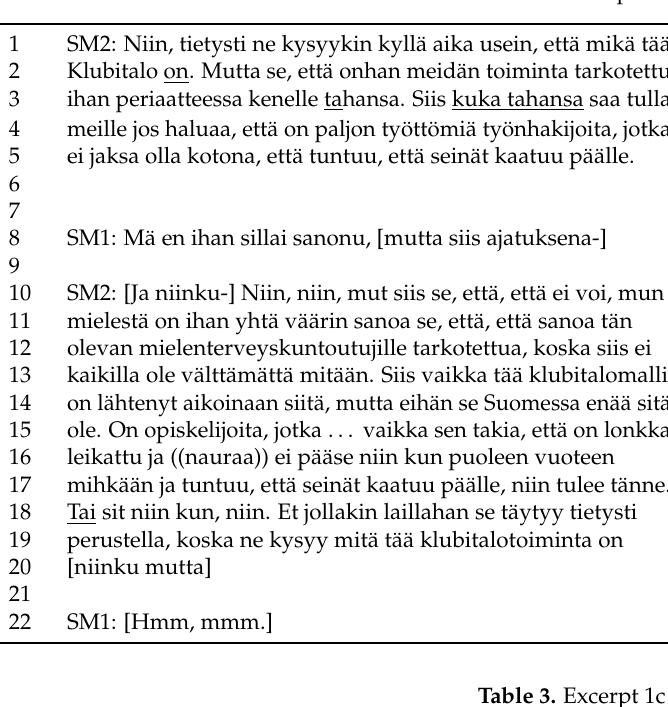
Table 2. Excerpt 1b (continuation).